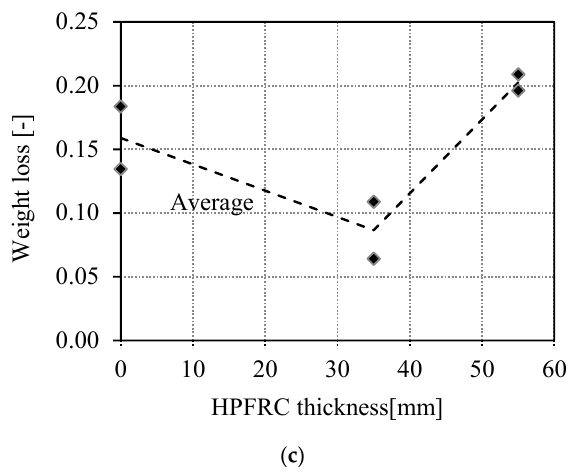
Figure 8. ( a ) Maximum and residual deflection; ( b ) energy absorbed in first and second stages of tests, respectively; ( c ) weight loss of specimens.